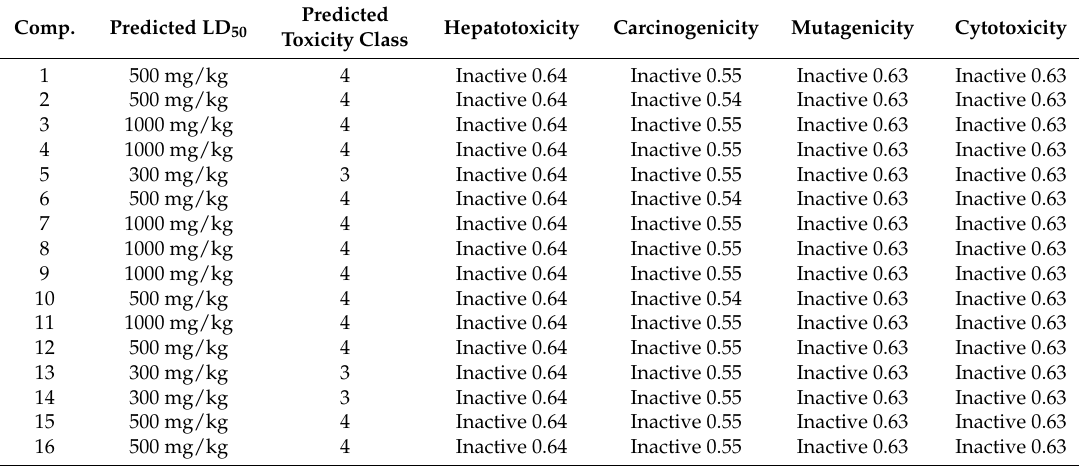
Table 4. Toxicity prediction by PTOTOX software.